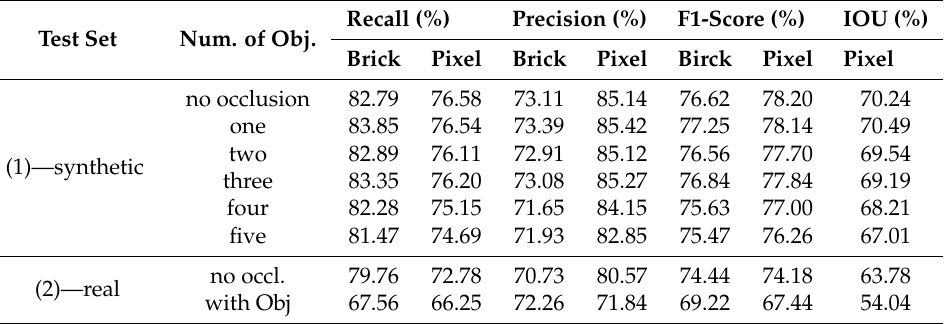
Table 3. Evaluation of brick segmentation. Object and pixel level precision, recall, F1-score and IOU values for the Test Set (1) using different numbers (0–5) of synthetic occluding objects; and results on Test Set (2) with real occlusions. Recall (%) Precision (%) F1-Score (%) IOU (%) Test Set Num. of Obj. Brick